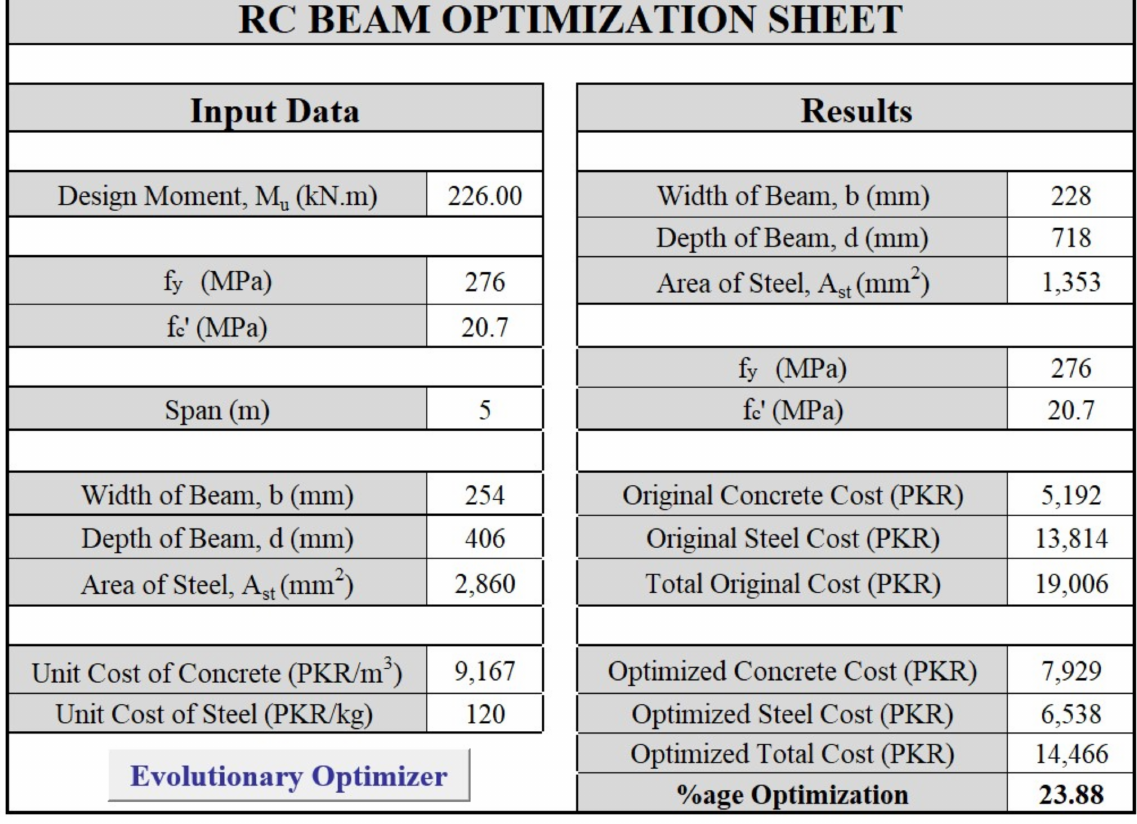
Figure 1. The interface for the RC beam